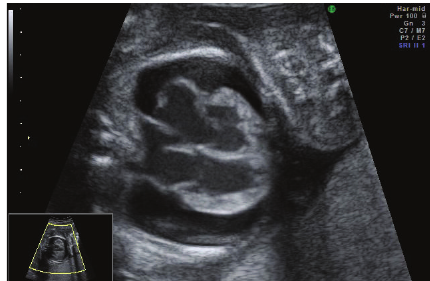
Figure 1: Fetal echocardiography at 21 weeks of gestation. A 2D image of the four-chamber view showed cardiomegaly, dilated ventricles, and atria with thickened and echo-dense walls, as well as massive pericardial